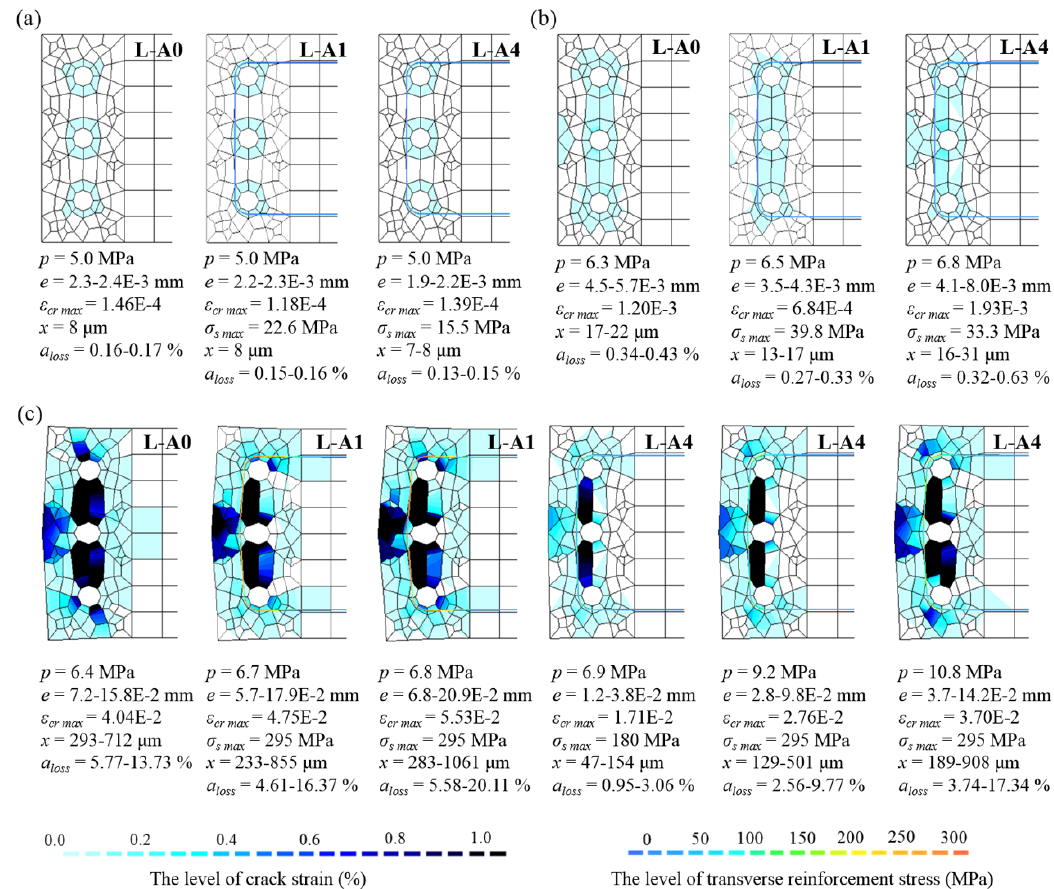
Figure 12. Comparisons of concrete cracking induced by corrosion at each step: ( a ) early corrosion; ( b ) cracking reaching the surface of concrete; ( c ) final cracking progress.